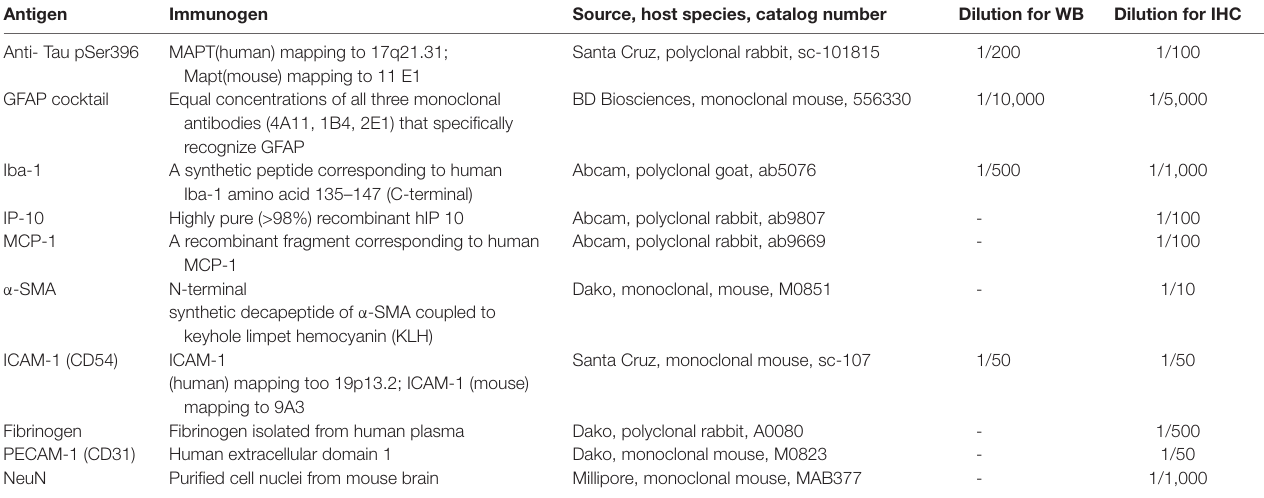
TABLE 1 | Primary antibodies used in this study.